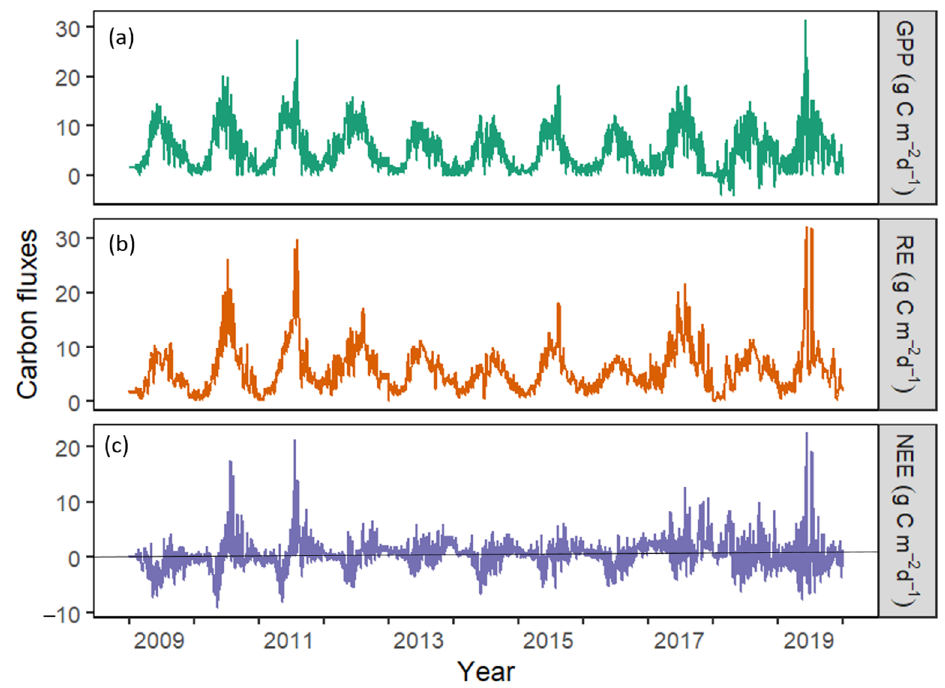
Figure 3. Seasonal variation in ( a ) gross primary productivity (GPP), ( b ) ecosystem respiration (RE), and ( c ) net ecosystem exchange (NEE) from 2009–2019. Daily data were obtained from the eddy covariance flux tower (US-NC4) in Alligator River National Wildlife Refuge, Dare County, North Carolina, USA. Table 1. Annual gross primary production (GPP), ecosystem respiration (RE), and net ecosystem exchange (NEE) from 2009 to 2019. The upper and lower limits were determined using the uncertainty analysis of [57] for NEE, while Monte Carlo (bootstrap) simulation was used for GPP and RE.